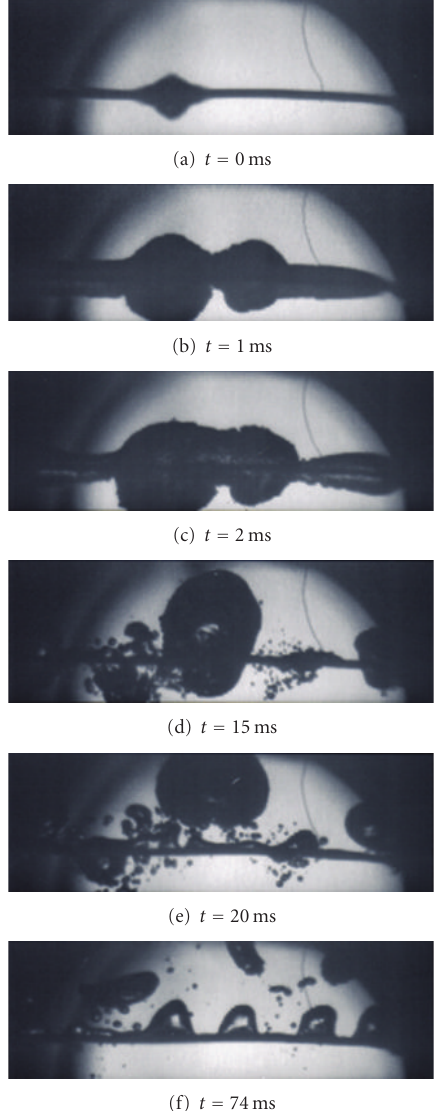
Figure 5: Vapor film behavior during direct transition to film boiling for a period of 0.1 s at a pressure of 101.3 kPa in saturated